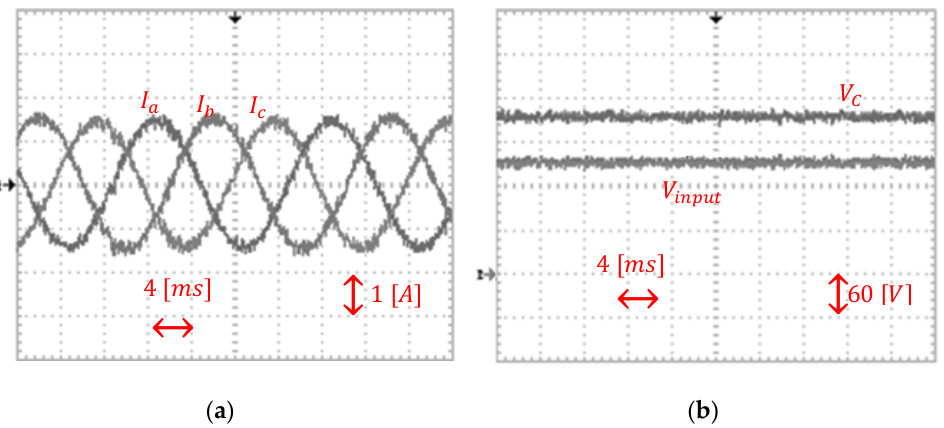
Figure 14. Three phase load current and input voltages: ( a ) Three phase load current; ( b ) input voltage and capacitors’ voltages.